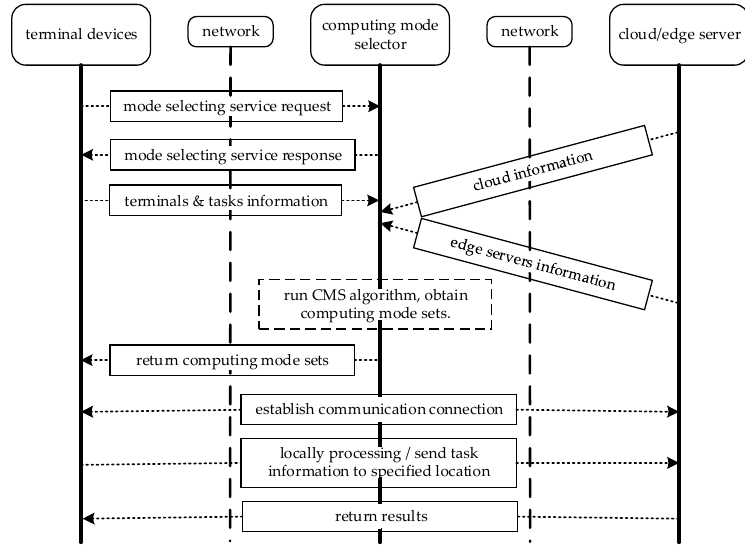
Figure 2. Signaling process for CMS.